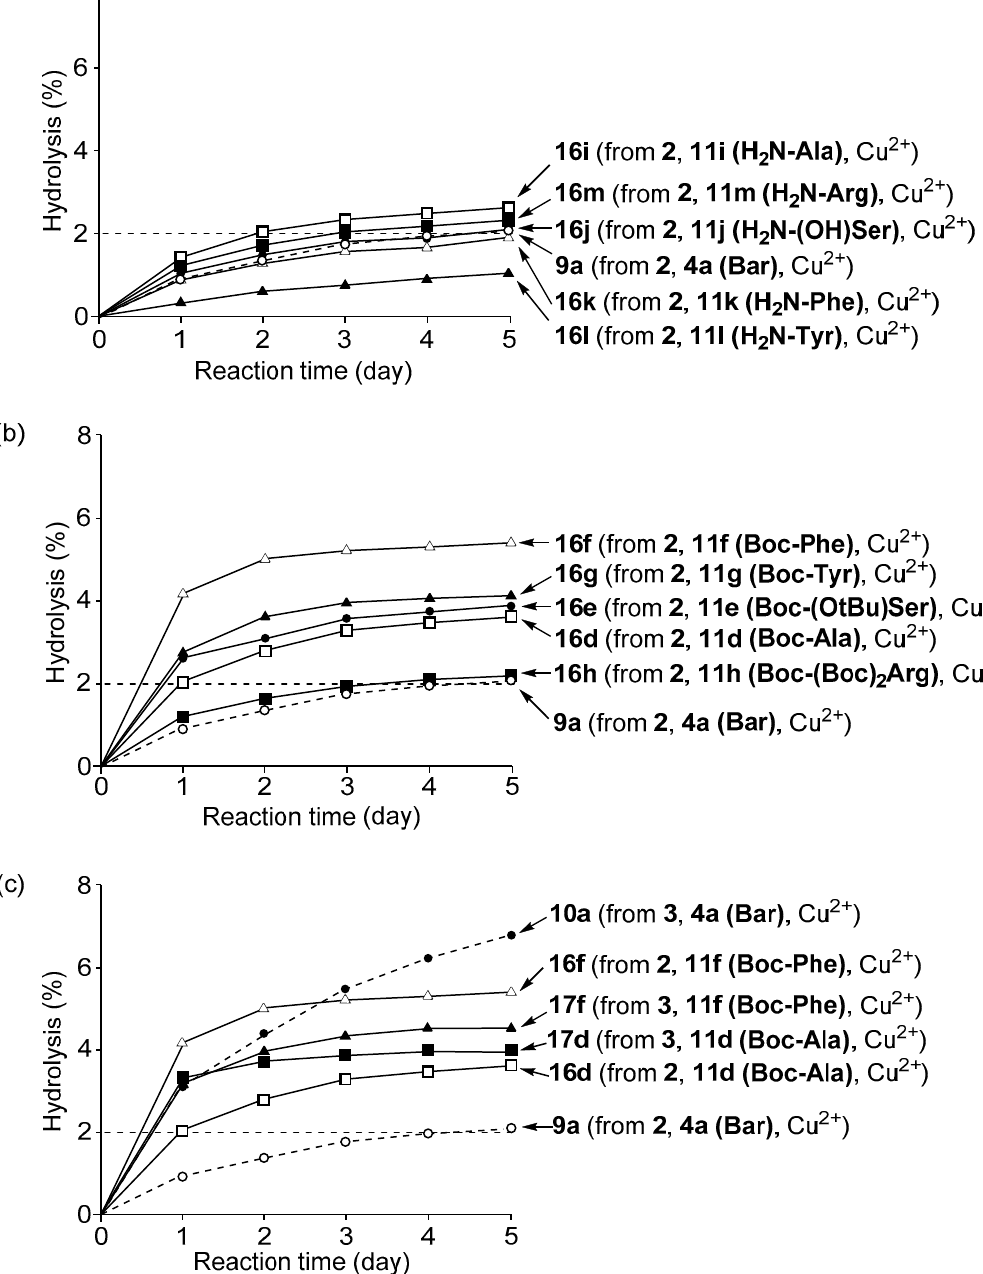
Figure 8. Hydrolysis of MNP (1000 µ M in the total solution) by ( a ) 9a (open circles with dashed curve), 16i (open squares), 16j (closed circles), 16k (open triangles), 16l (closed triangles), or 16m (closed squares); ( b ) The hydrolysis of MNP by 9a (open circles with dashed curve), 16d (open squares), 16e (closed circles), 16f (open triangles), 16g (closed triangles), or 16h (closed squares); ( c ) The hydrolysis of MNP by 9a (open circles with dashed curve), 10a (closed circles with dashed curve), 16d (open squares), 16f (open triangles), 17d (closed squares), 17f (closed triangles) ([ 9 , 16 , 17 ] = 20 µ M in the total solution) in CHCl 3 / 50 mM HEPES bu ff er (pH 7.4) with I = 0.1 (NaNO 3 ) (2 / 8) at 37 ◦ C. The concentrations of the product (4-nitrophenol) were determined in the total two-phase system.